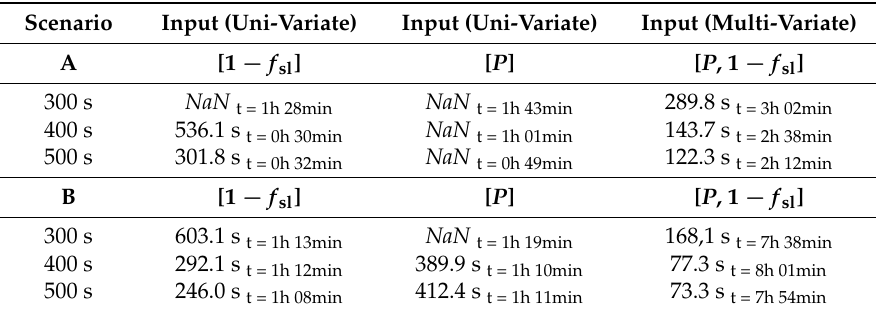
Table 3. Results of computations of scenario A and scenario B.